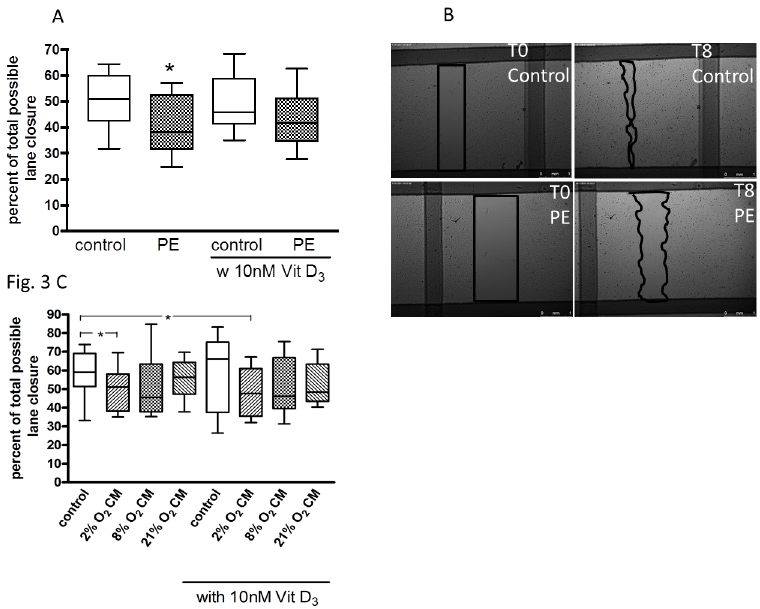
Fig 3. Effect of preeclampsia(PE), preeclampsia-like conditions and 1,25(OH) 2 vitamin D 3 on HUVEC migration. (A) HUVEC of uncomplicated (control) and PE pregnancieswere cultured in endothelial basal medium (EBM) and treated with or without 10 nM 1,25(OH) 2 vitamin D 3 . The migration of PE HUVEC into the scratch woundassessedafter incubationfor 18 h was decreased comparedto control. (B) "scratch wound"at 0 h and 8 h incubation is shown. Scale bar represents 750 μ m. (C) Effect of villousexplant conditioned medium (2% O 2 , 8% O 2 , 21% O 2 CM) and 1,25(OH) 2 vitamin D 3 on HUVEC migration with a reduction at 2% O 2 . * P < 0.05 vs. untreatedcontrol. The ends of the whiskersrepresent the maximum and minimum measuredvalues. Distributionwas examinedusing Kolmogorov- Smirnov test. Continuous data were comparedwith unpairedt-test (A) or Wilcoxon-signed rank test